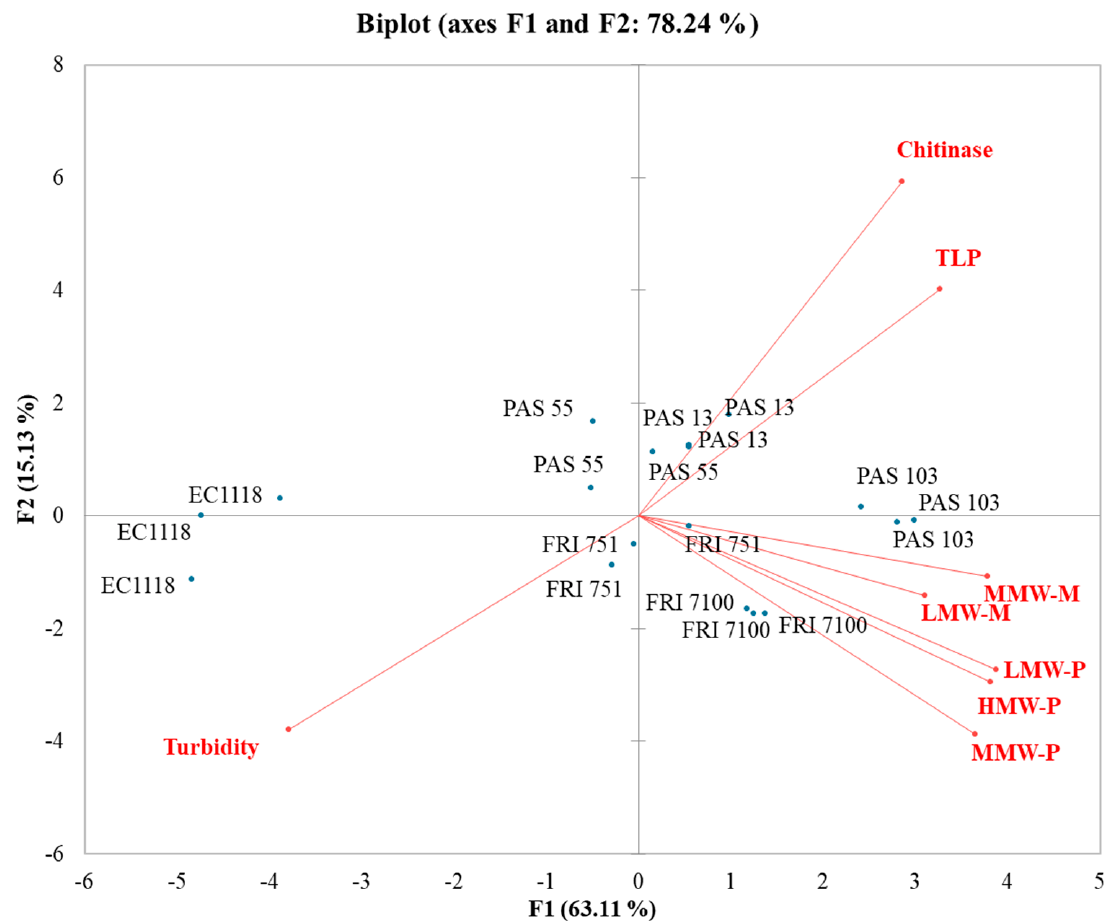
Figure 3. Principal component analysis (PCA) biplot of turbidity, grape proteins, polysaccharides, and mannoproteins in Sauvignon blanc wines.